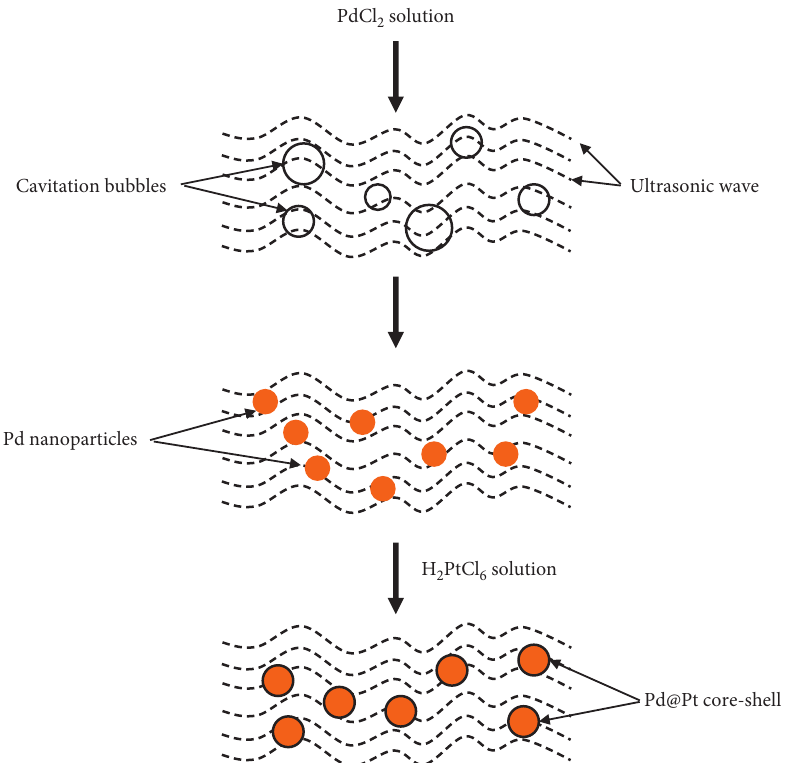
Figure 10: Schematic illustration for the synthesis of Pd@Pt core shell using ultrasonication. Reproduced from [86] under the terms of the Creative Commons CC BY